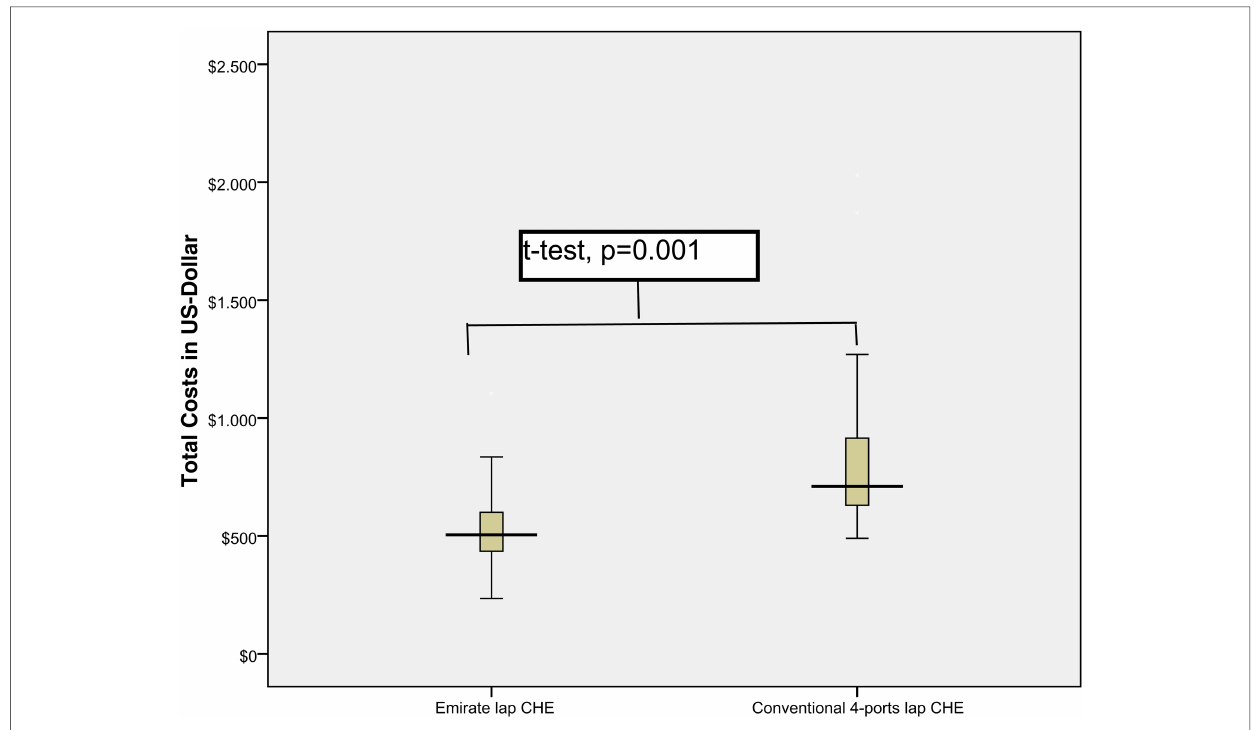
FIGURE 4 Comparison of total consumable costs and operating room utilization per minute for emirate laparoscopic cholecystectomy versus conventional four-port laparoscopic cholecystectomy.